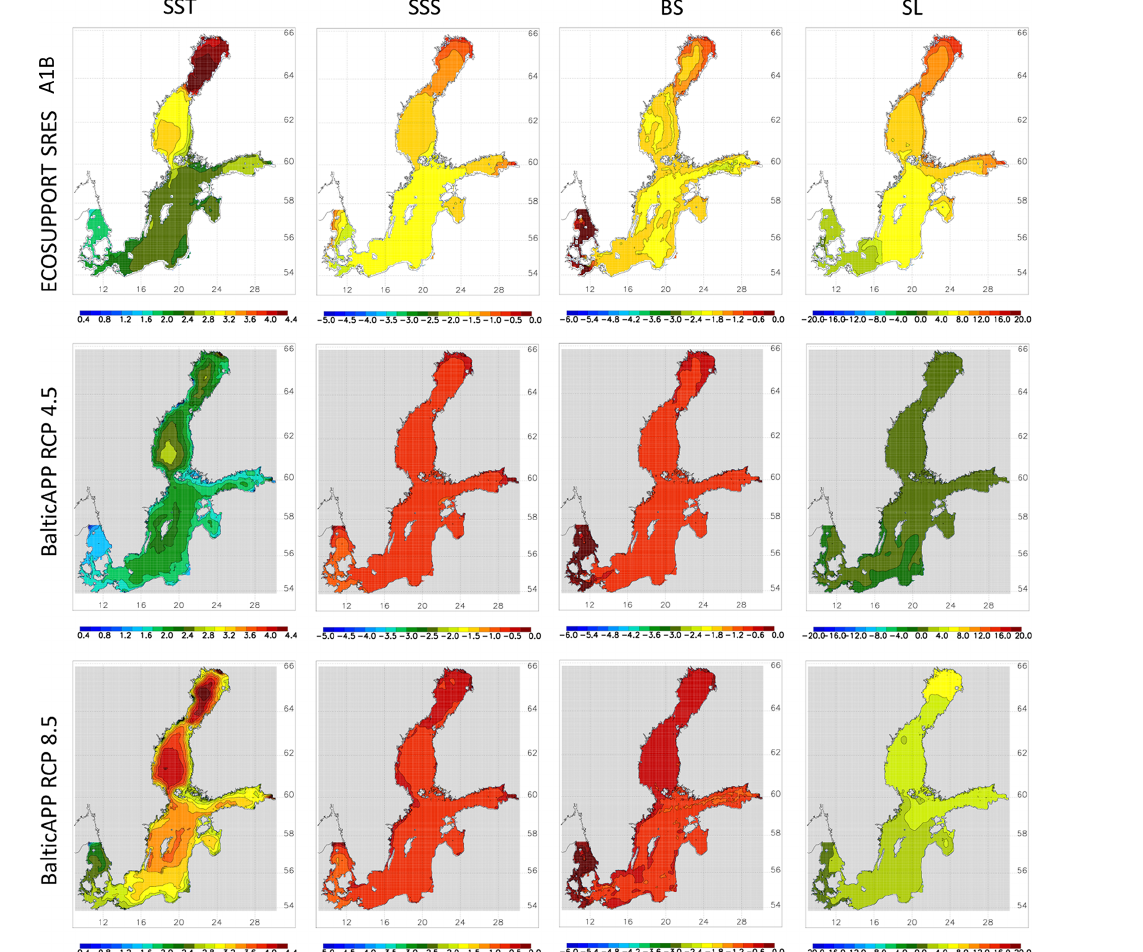
Figure 12. From left to right, changes in the mean SST ( ◦ C) in summer (June–August), the annual mean sea surface salinity (SSS; gkg − 1 ), annual mean bottom salinity (BS; gkg − 1 ) and winter (December–February) mean sea level (SL; cm) between 1978–2007 and 2069–2098. From top to bottom, the results of the ensembles ECOSUPPORT (white background, Meier et al., 2011b), BalticAPP RCP4.5 (grey back- ground, Saraiva et al., 2019a) and BalticAPP RCP8.5 (grey background, Saraiva et al.,